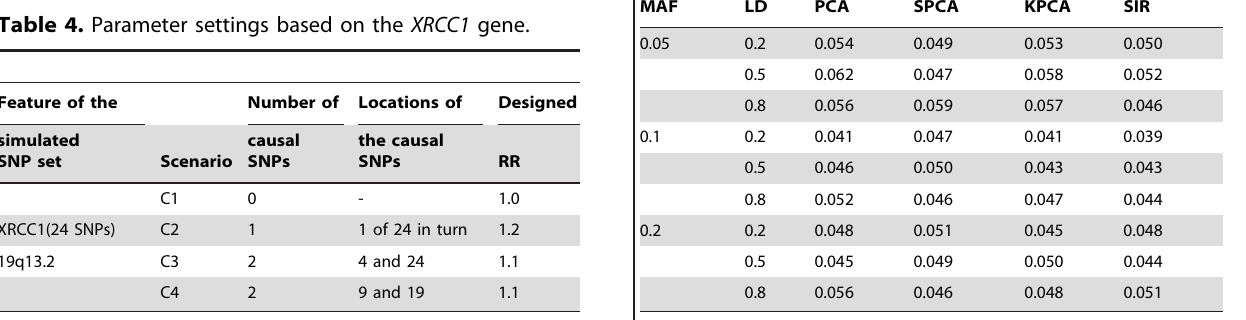
Table 4. Parameter settings based on the XRCC1 gene.